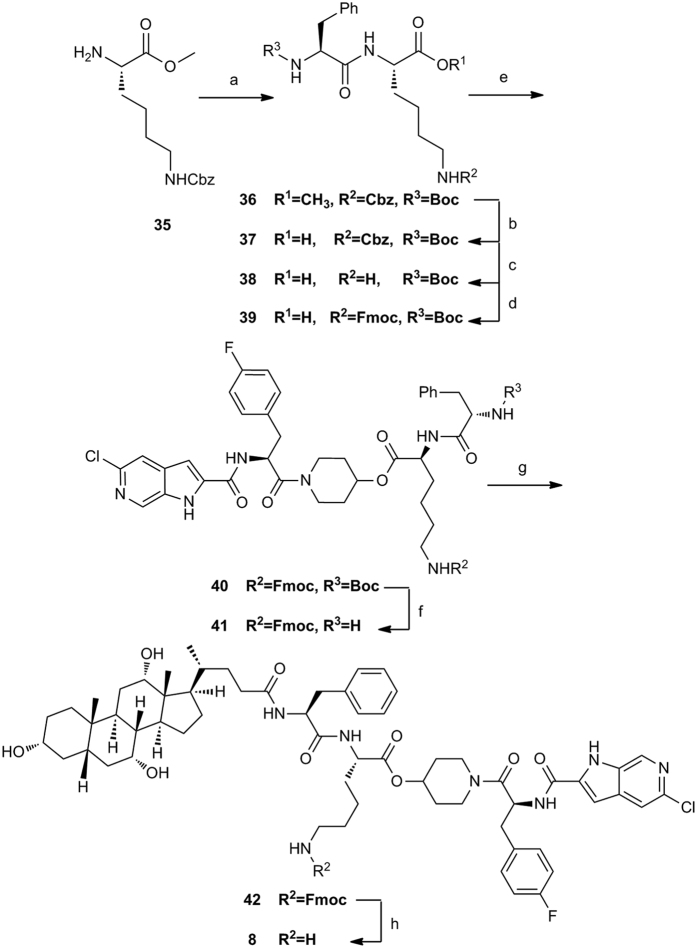
Synthesis of conjugate 8a.Reagents and conditions: (a) Boc-L-phenylalanine, EDCI, HOBt, DIPEA, DMF, rt, 73%; (b) NaOH, MeOH/H2O, rt, 79%; (c) H2, Pd/C, CH3OH, rt,; (d) FmocCl, NaHCO3, 1,4-dioxane, 0 °C; (e) PSN-357, T3P, CH2Cl2, rt, 3 steps 19.2% yield for 40; (f) TFA, CH2Cl2, 0 °C; (g) Cholic acid, HATU, Et3N, DMF, rt, 2 steps 48.5% yield for 42; (h) Piperidine, CH3CN, rt, 45%.